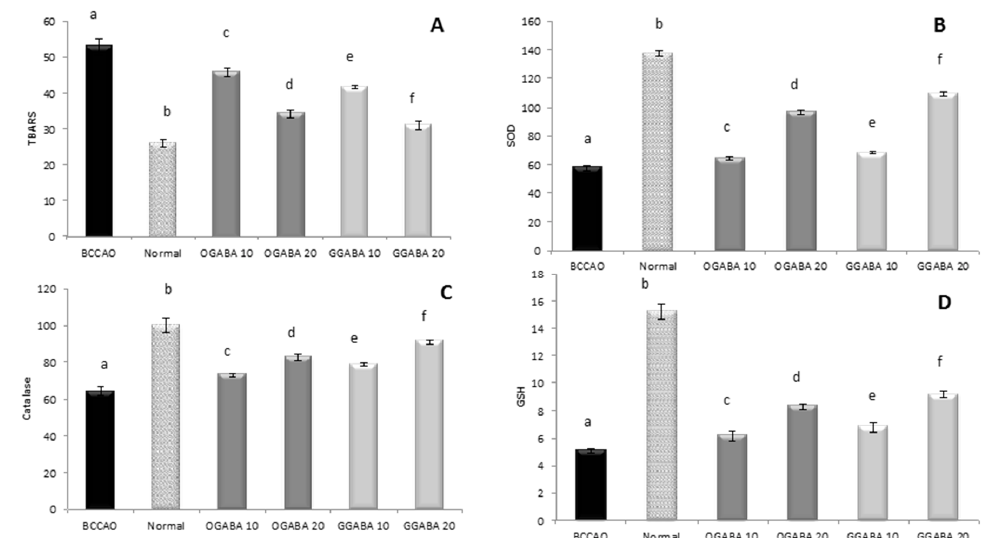
Figure 8. Effects of oral administration of OGABA and GGABA extracts on oxidative stress levels. In detail, thiobarbituric-reactive substances (TBARS) levels, expressed as nmol malondialdehyde (MDA) eq/g tissues ( A ); superoxide dismutase (SOD) activity, expressed as U/mg protein ( B ); Catalase activity, expressed as U/mg protein ( C ); and glutathione (GSH) levels, expressed as µ g/mg protein ( D ) in mouse brain tissue are reported. Data are mean ± SD ( n = 7); different letters indicate statistically significant differences ( p < 0.05) between the two groups.